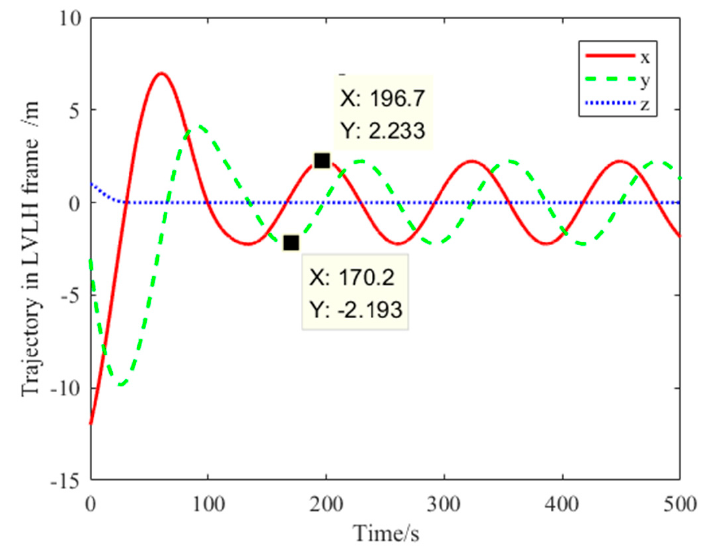
Figure 10. Time response of relative position in local vertical local horizontal (LVLH) frame.